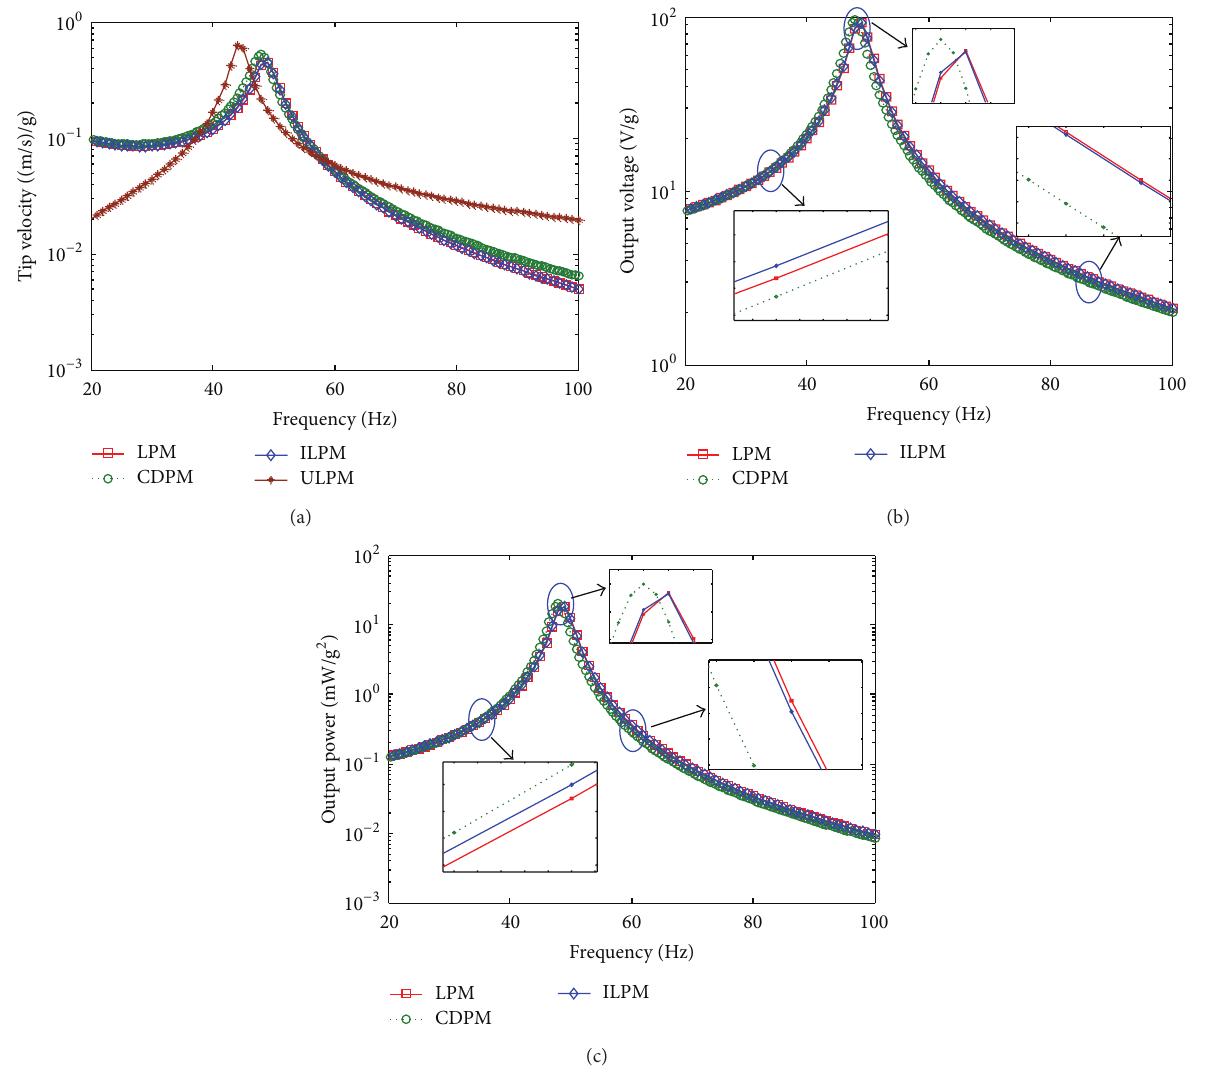
Figure 13: Comparison of analytical results of LPM, CDPM, ULPM, and ILPM when 𝑅 𝐿 = 470 k Ω : (a) tip velocity, (b) output voltage, and (c) output